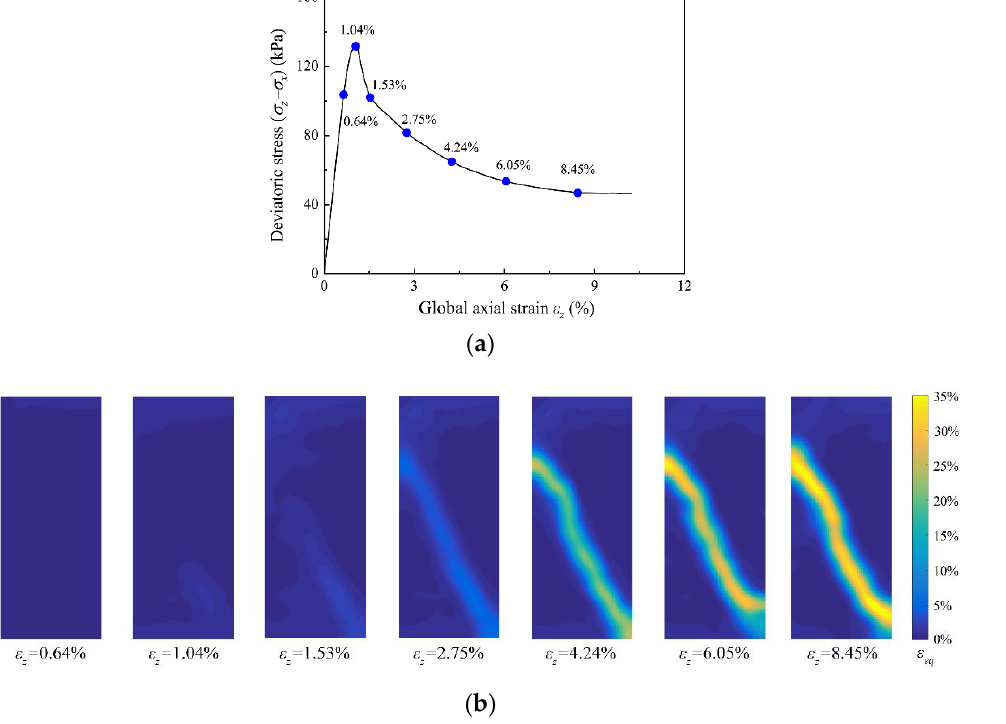
Figure 7. Results of DIC analyses for the T1 test: ( a ) global stress – strain relationship for the T1 test; ( b ) shear strain distribution at different stages in the T1 test.